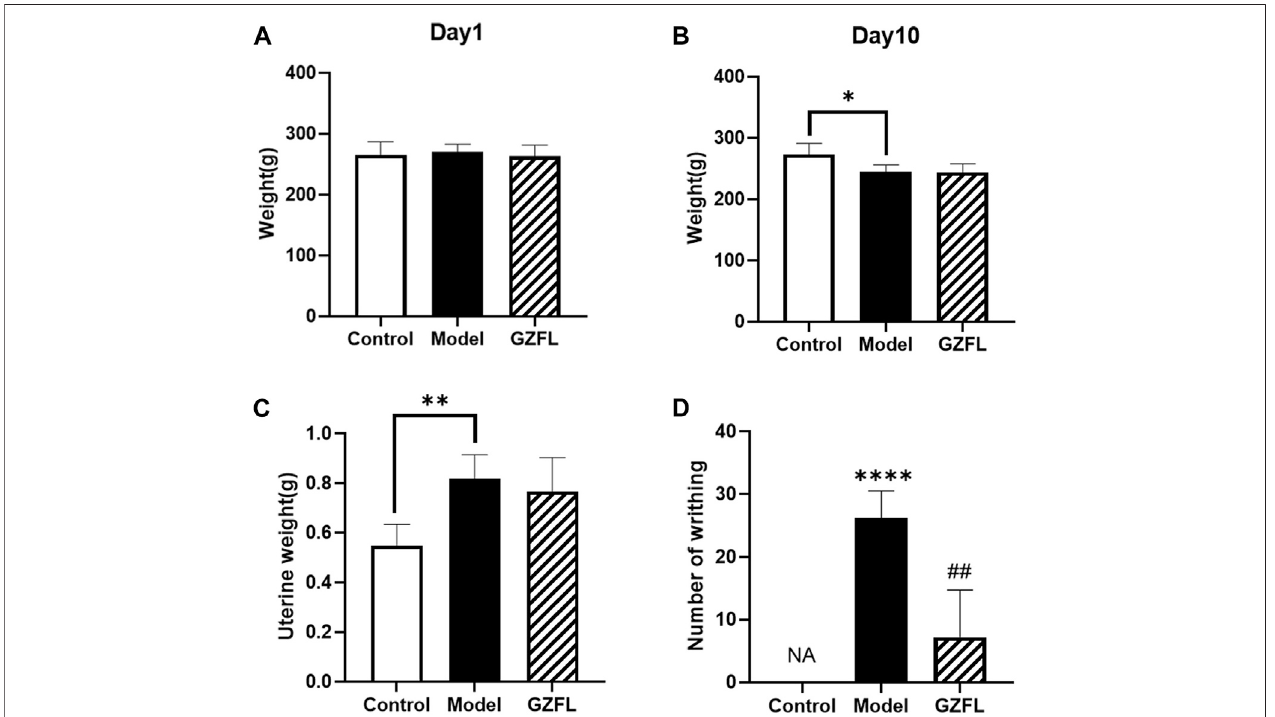
FIGURE1|(A) Theweight ofthe raton day1ofthe experiment (B) Theweight oftherat onday 10 (C) theweightofthe uterus onday 10oftheexperiment (D) the number of writhings recorded on day 10 of the experiment. (x ± s , n (cid:2) 6, compared with Control group: * p < 0.05 ** p < 0.01 *** p < 0.001 **** p < 0.0001; compared with Model group: # p < 0.05 ## p < 0.01 ### p < 0.001 #### p <